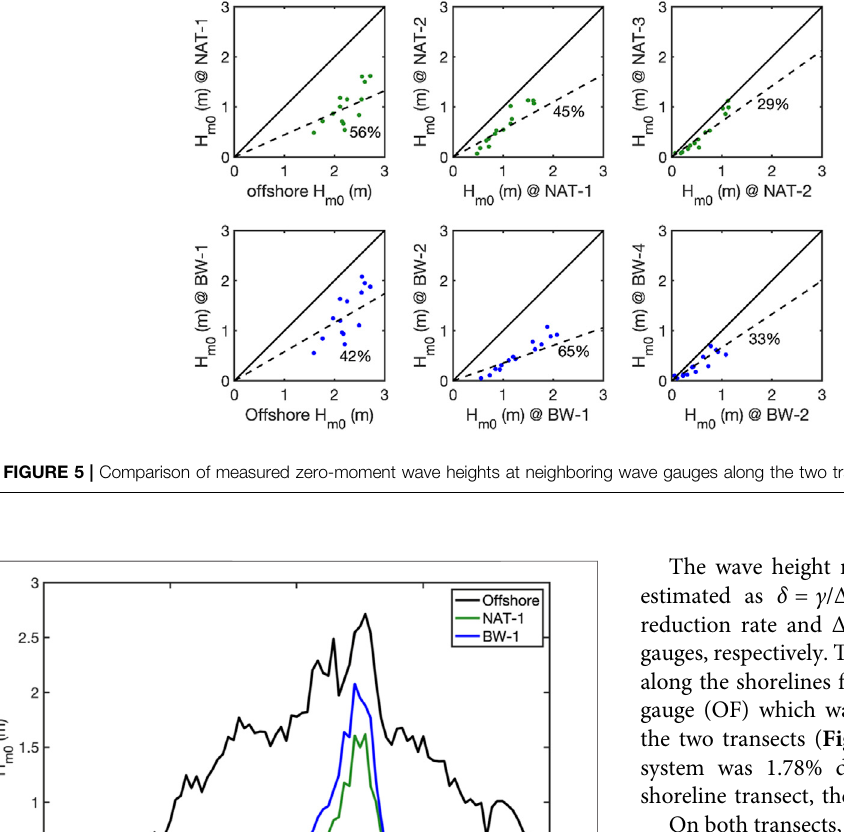
Frontiers in Built Environment |